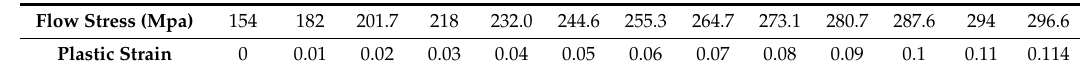
Table 4. Multi-linear stress-strain relations used for the finite element analysis of punching process from the uniaxial tensile test.